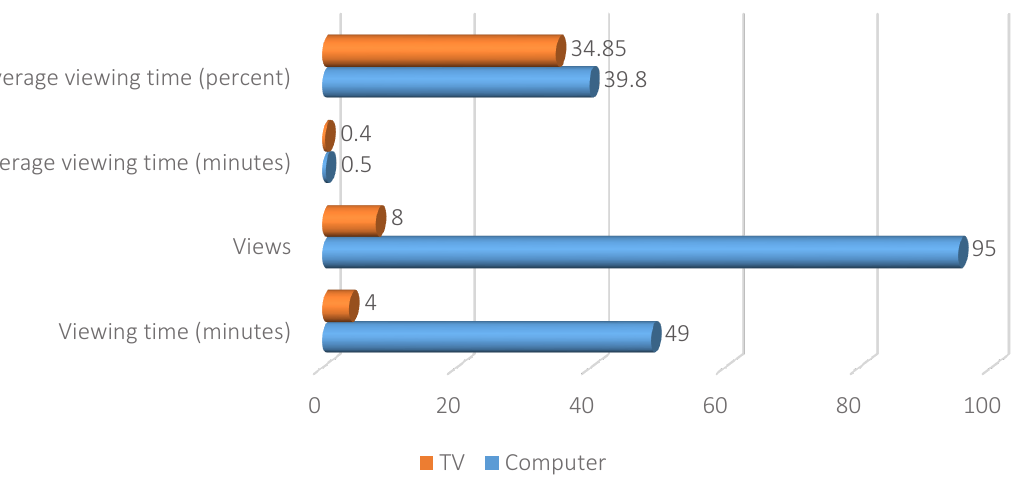
Figure 8. Analysis of length of viewing a video clip for 21 days of observation for computer and TV